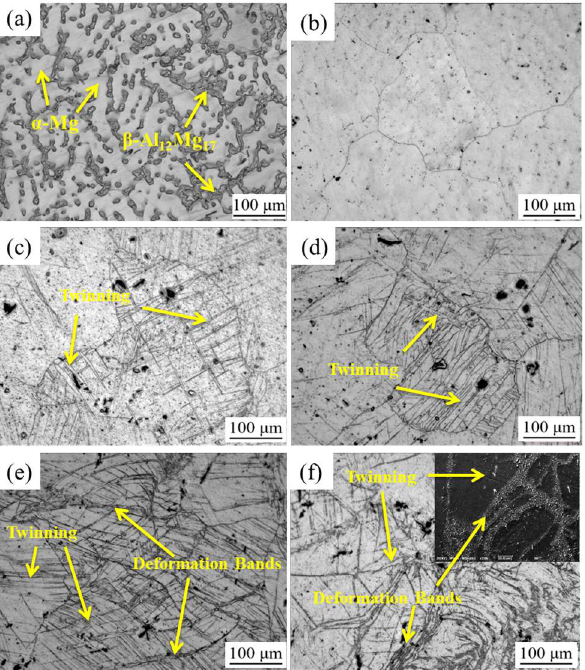
Figure 1. Microstructures of the ( a ) as-cast, ( b ) H, ( c ) 20%-HR, ( d ) 40%-HR, ( e ) 60%-HR, and ( f ) 70%-HR alloys.